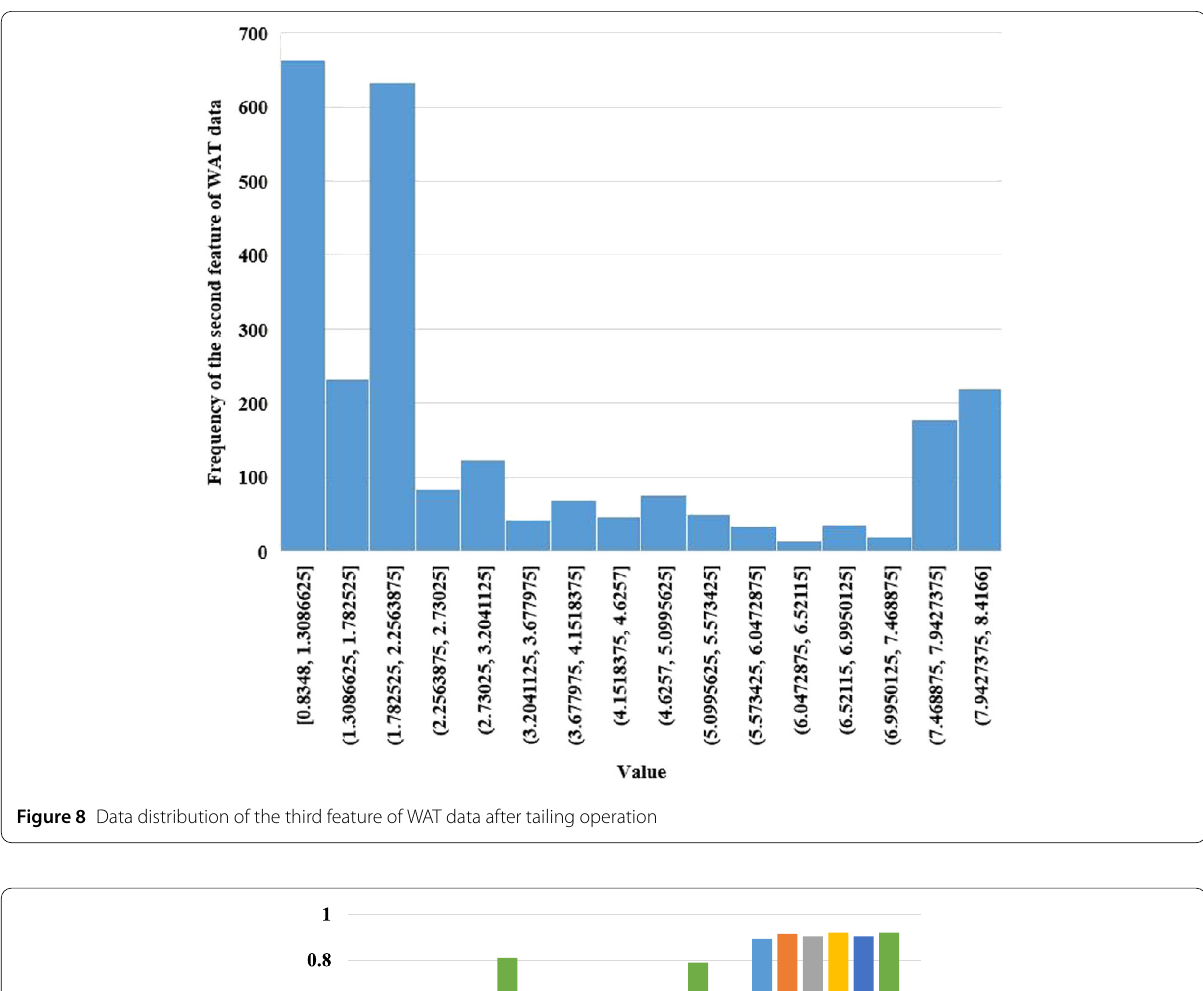
Figure 8 Data distribution of the third feature of WAT data after tailing operation